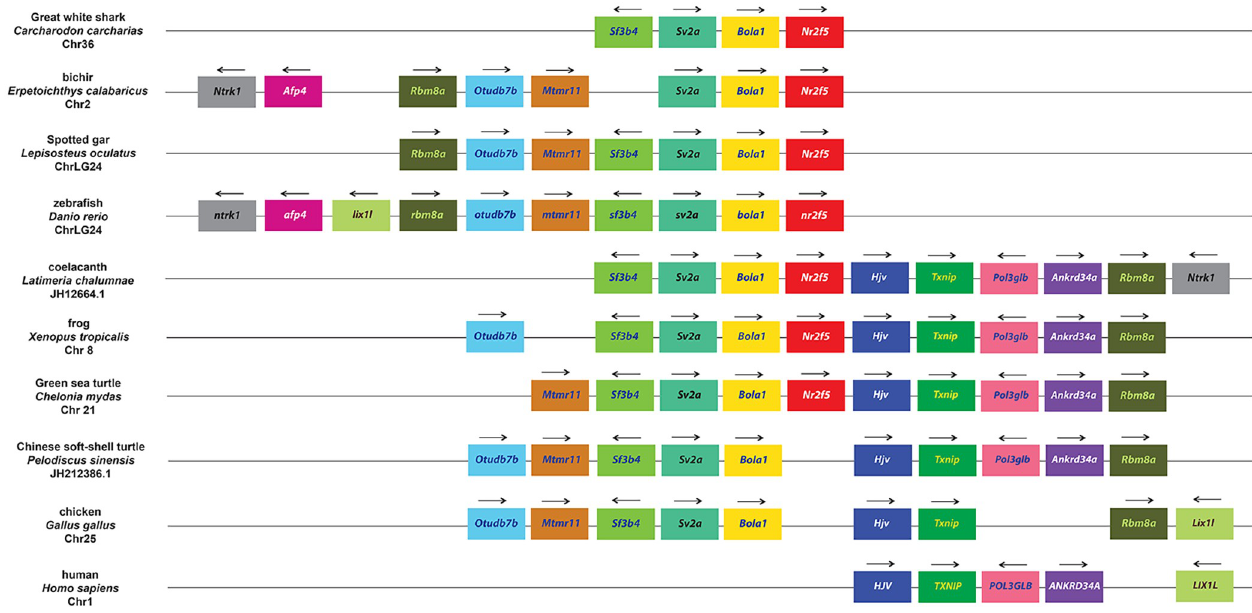
Fig 7. Synteny analysis of vertebrate Nr2f5 genes. Schematization of conserved genomic environments of gnathostome Nr2f5 genes (red rectangles) in selected species with relative chromosomes/scaffolds. Flanking orthologous genes are represented using rectangles of the same color. Arrows indicate transcription